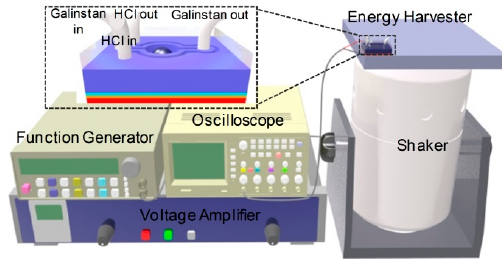
Figure 8. Experiment setup comprising of the reduced Galinstan-based microfluidic energy harvester, function generator, voltage amplifier, shaker and oscilloscope.